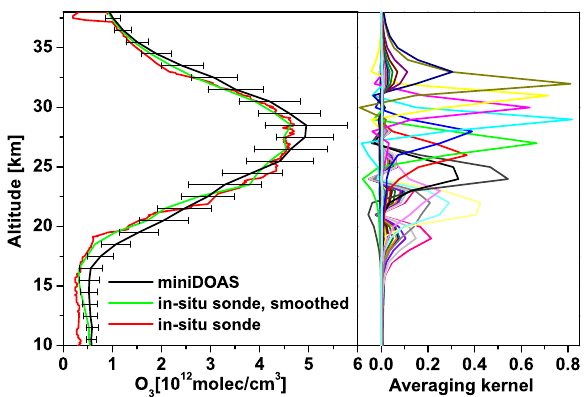
Fig. 7. Left panel: Concentration profile of O 3 retrieved from mini-DOAS measurements (black) aboard the MIPAS-B payload on June 14, 2005 and from an in-situ sonde (red) in the vicinity of the balloon flight, smoothed with the averaging kernels of the mini-DOAS retrieval (green). Right panel: Averaging kernels of the mini-DOAS retrieval of O 3 . Different colours denote different EA.